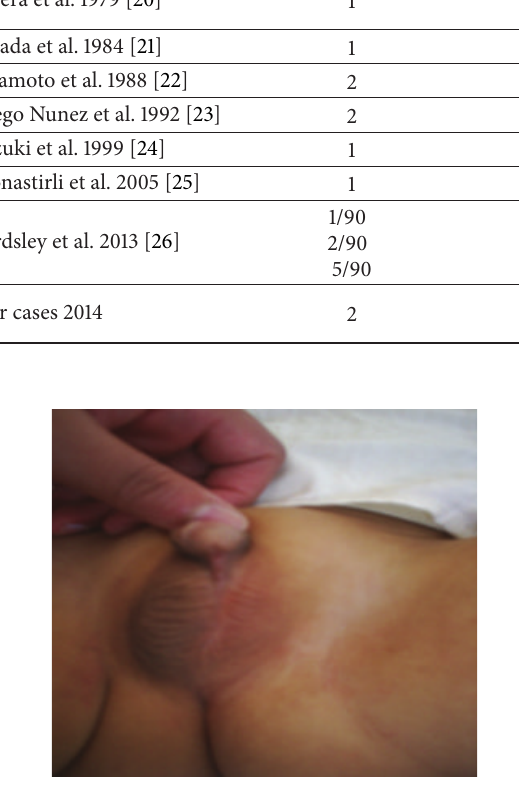
Figure 5: Case 2: hypospadias.